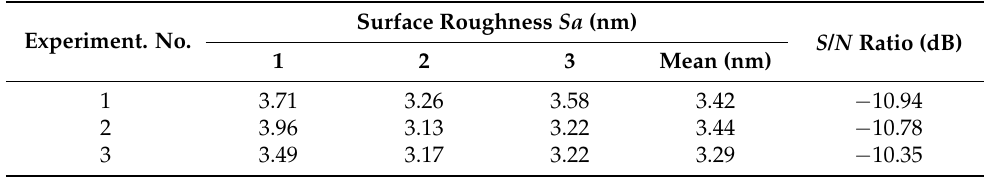
Table 6. Sample polishing results of the confirmation